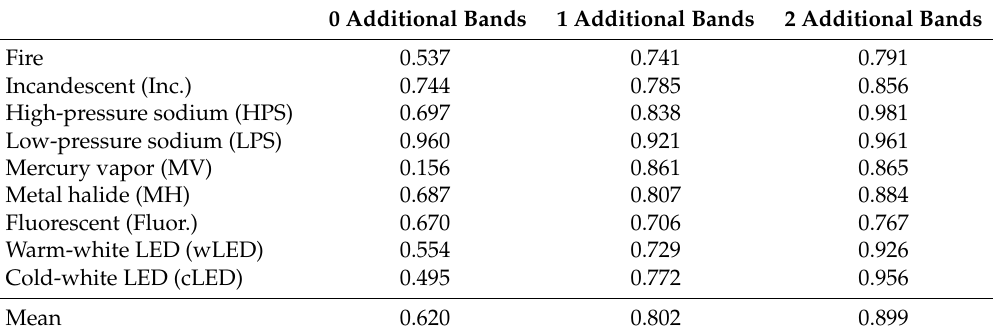
Table 1. F1 scores per lighting type for 0, 1, and 2 additional bands. 0 Additional Bands 1 Additional Bands 2 Additional